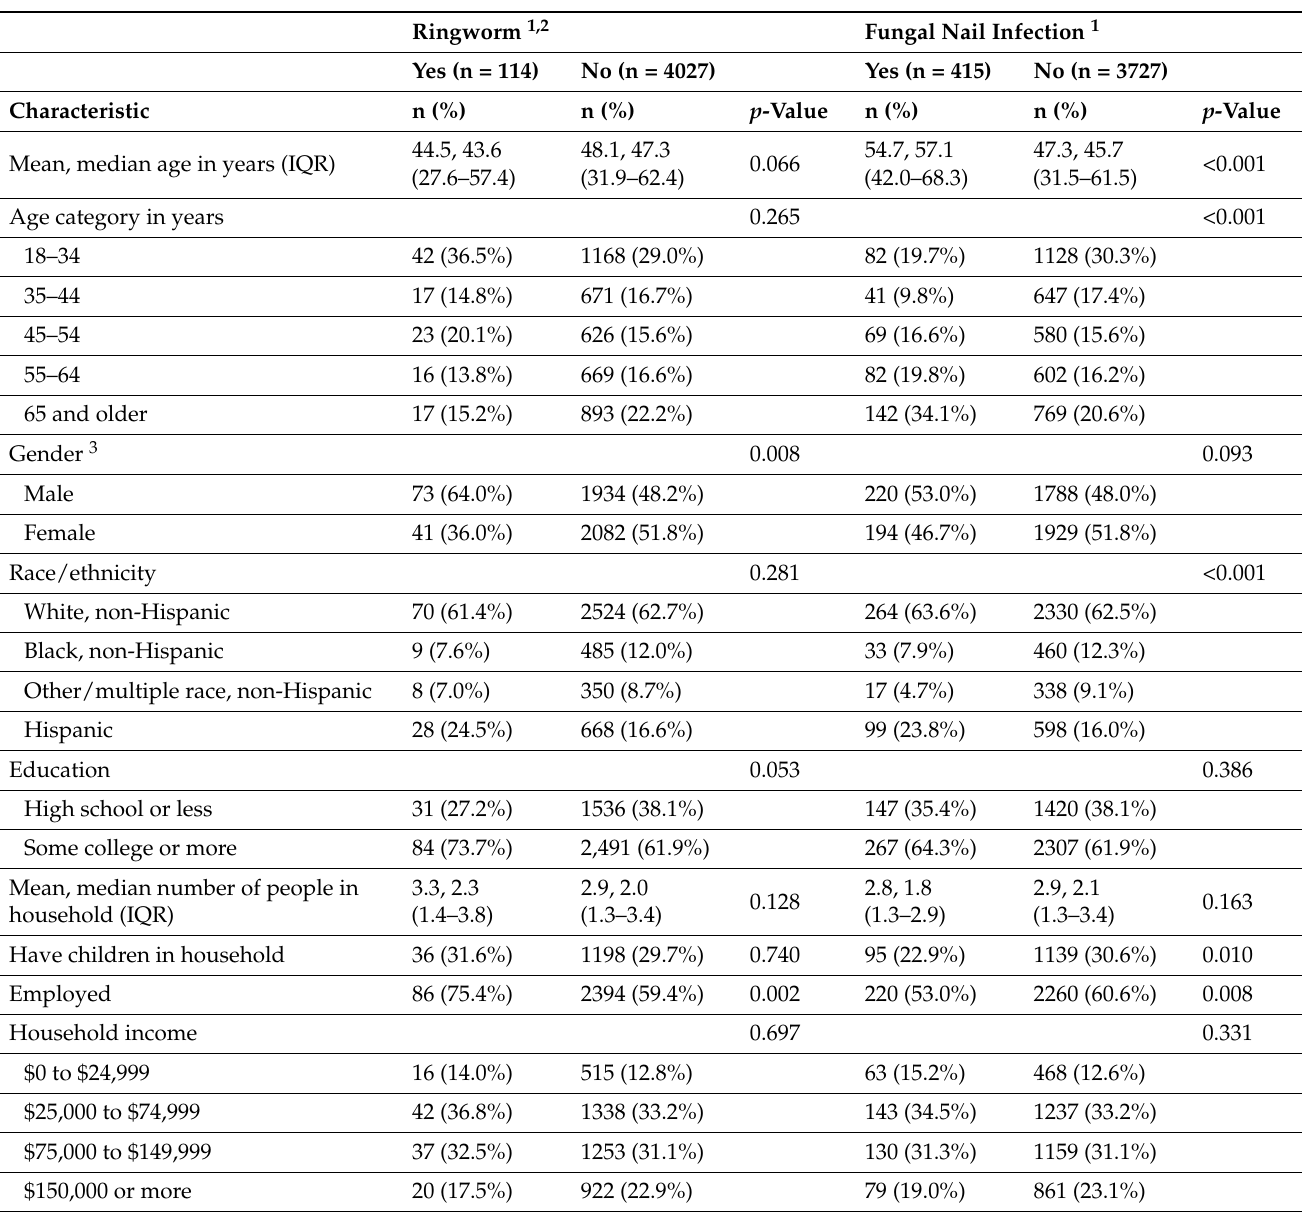
Table 1. Demographic characteristics and health-related features associated with having ringworm or fungal nail infection in the past 12 months—Porter Novelli Summer ConsumerStyles Survey, United States,